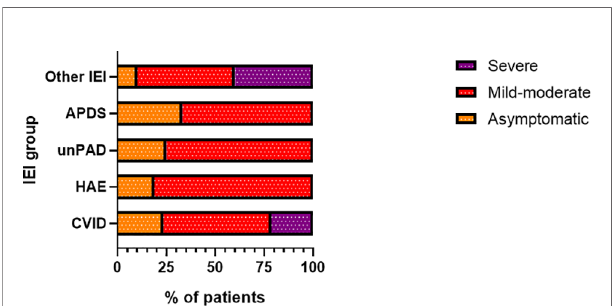
FIGURE 4 | Proportion of patients (n= 81) according to disease severity in particular inborn erorrs of immunity (IEI) categories (CVID, common variable immunode fi ciency, n = 47/81; HAE, hereditary angioedema, n = 16/81; unPAD, unclassi fi ed primary antibody de fi ciency; n = 4/81; APDS, Activated phosphoinositide 3-kinase d syndrome, n = 3/81; IEI, n